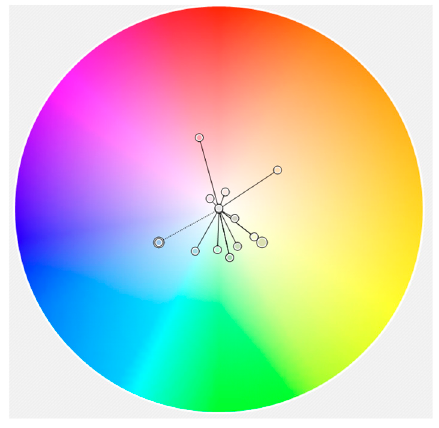
Figure 6. The OpenStreetMap color analysis.